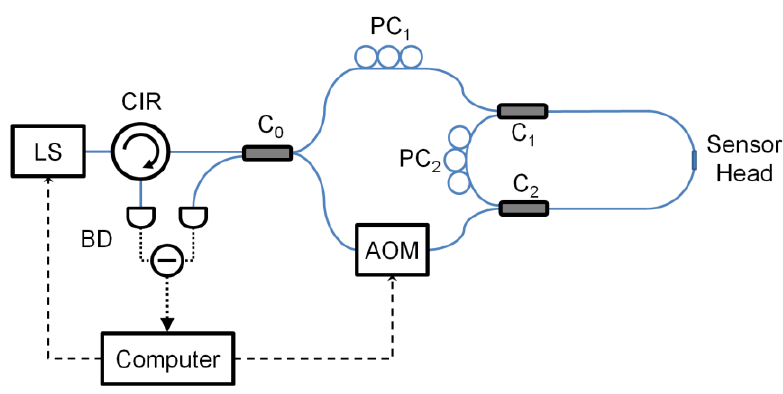
: 50/50 fiber directional 0